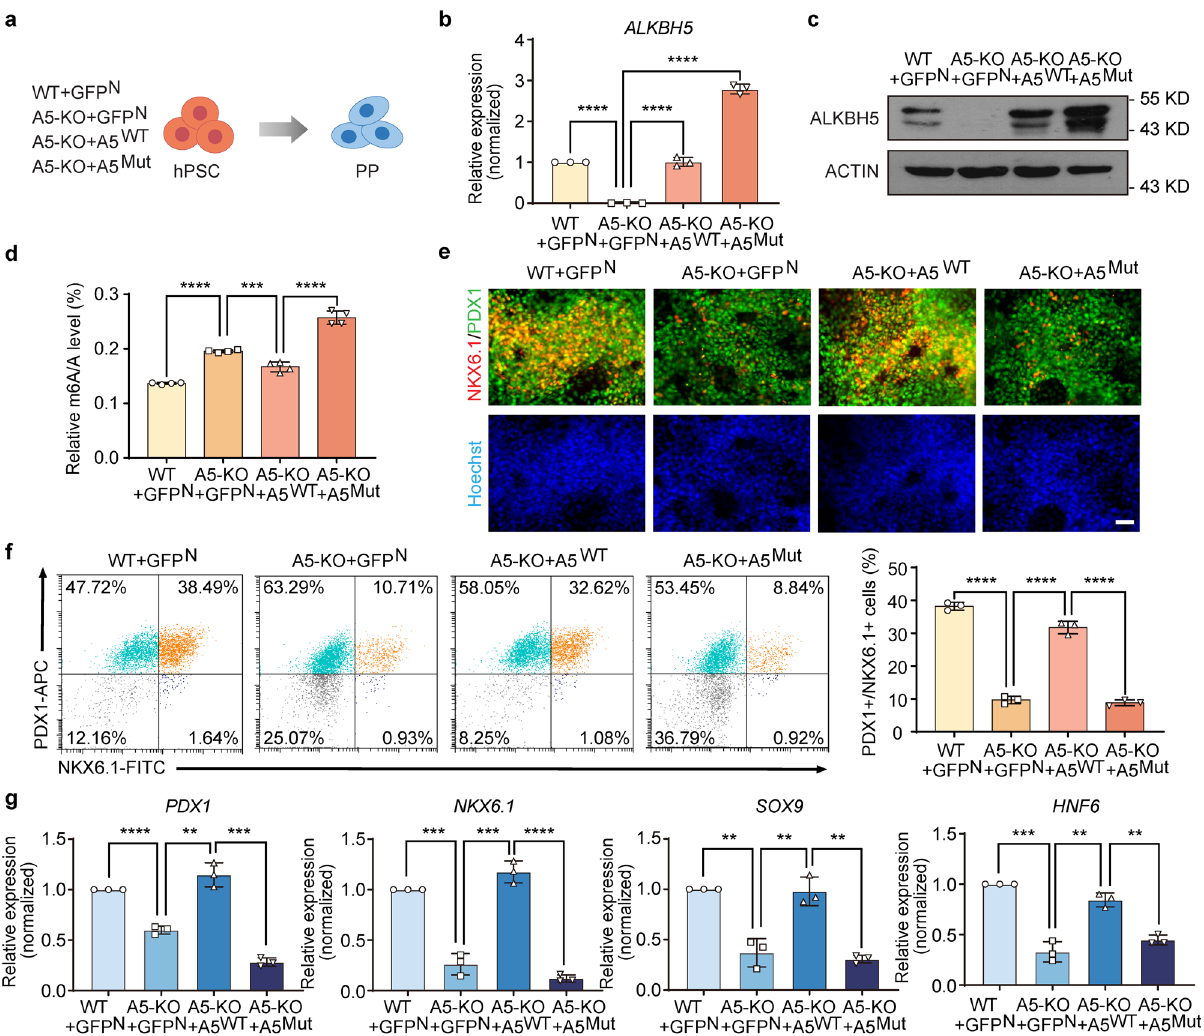
Fig. 5 Demethylation activity of ALKBH5 is required for human pancreatic differentiation. a A schematic representation of the rescue experiment. WT + GFP N , A5-KO + GFP N , A5-KO + A5 WT , and A5-KO + A5 Mut hPSC lines were used. b RT-qPCR analysis of the expression of ALKBH5 ( n = 3 biological replicates). c Western blotting analysis of ALKBH5 protein levels in WT + GFP N , A5-KO + GFP N , A5-KO + A5 WT , and A5-KO + A5 Mut hPSC lines. ACTIN was used as a loading control. Images are representative of three independent replicates. d The quanti fi cation of m 6 A abundance in WT + GFP N , A5-KO + GFP N , A5-KO + A5 WT , and A5-KO + A5 Mut hPSC lines by UHPLC-QQQ-MS/MS ( n = 4 biological replicates). e Immuno fl uorescent staining of PDX1, NKX6.1, and nuclei. Images are representative of three independent replicates. Scale bar, 100 μ m. f Representative fl ow cytometry plots and the percentage of PDX1 + NKX6.1 + cells in WT + GFP N , A5-KO + GFP N , A5-KO + A5 WT , and A5-KO + A5 Mut PP populations ( n = 3 biological replicates). g RT-qPCR analysis of PDX1 , NKX6.1 , SOX9 , and HNF6 expression ( n = 3 biological replicates). All data are presented as mean ± s.d. Statistical signi fi cance calculated using two-tailed Student ’ s t -test, ** p < 0.01, *** p < 0.001, **** p < 0.0001. Source data are provided as a Source Data fi